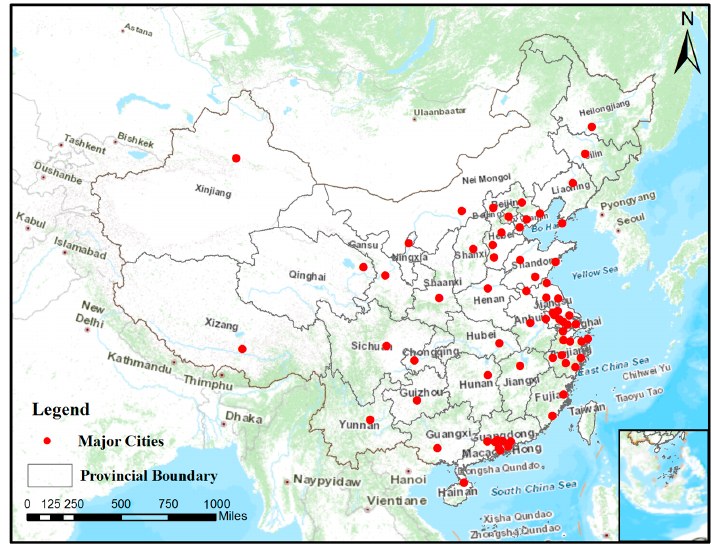
Figure 1. Study area: 68 major cities in China.